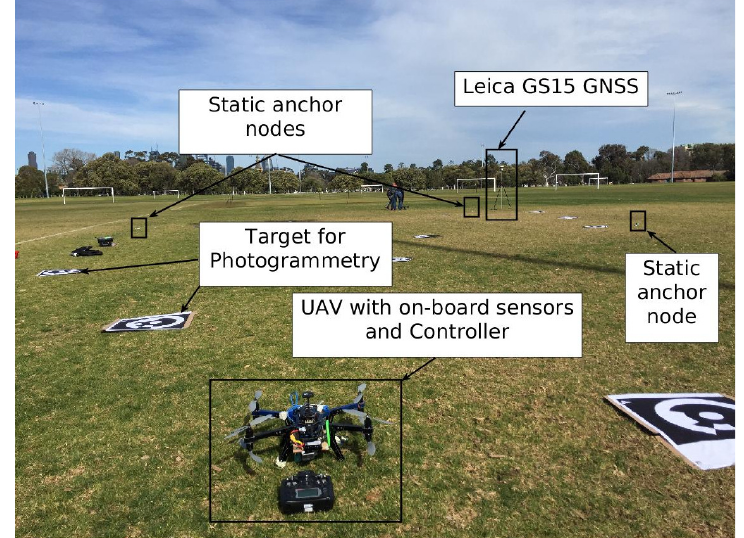
Figure 5. Image showing experimental setup for cooperative UAV localization.